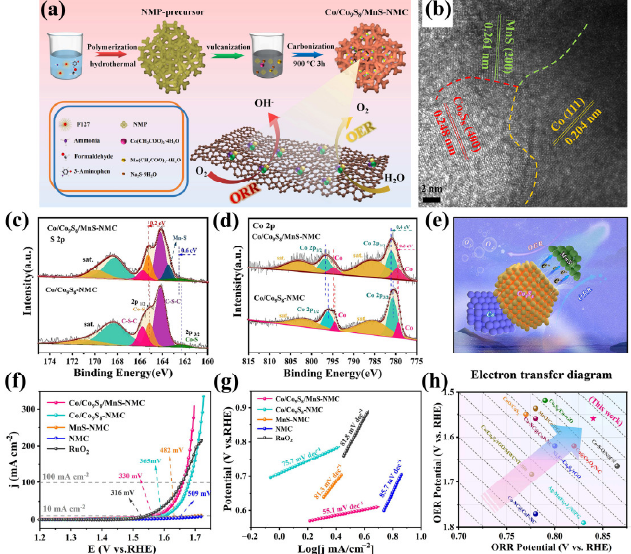
Figure 8. ( a ) Preparation process for Co/Co 9 S 8 /MnS-NMC. ( b ) HRTEM images of the Co/Co 9 S 8 /MnS- NMC. ( c ) S 2p XPS spectra and ( d ) Co 2p XPS spectra for Co/Co 9 S 8 /MnS-NMC and Co/Co 9 S 8 -NMC. ( e ) The electron transfer between Mo–Schoky Co/Co 9 S 8 structure and MnS species in Co/Co 9 S 8 /MnS-NMC. ( f ) OER polarization curves of Co/Co 9 S 8 /MnS-NMC in 1.0 M KOH, with a scan rate of 10 mV s −1 . ( g ) Corresponding Tafel plots for all investigated catalysts. ( h ) Comparison of OER and ORR activities of Co/Co 9 S 8 /MnS-NMC with representative samples. Reproduced with permis- sion from Ref. [90]. Copyright 2022, Elsevier B.V. 3.3. Self-Supporting Conductive Substrate Strategy Most transition metal-based catalysts used for water electrolysis are prepared on binder solid electrode support, which reduces the activity and durability of the catalyst system. In this regard, catalysts derived from a self-loaded metal–organic framework (MOF) have been introduced with a good conductivity, a high electrocatalytic surface area, enhanced mechanical stability, and strong catalyst–support interactions [91–96]. MOFs are porous crystalline materials in which the metal centers are connected by coor- dination bonds via organic bridging ligands to synthesize core–shell and hollow struc- tures. Self-supporting MOF-derived catalyst systems can be designed by controlling sur- face and interface properties (Figure 9a). A self-supporting catalyst was grown directly on a 3D solid and conductive support in situ without the use of any binders or additives. In general, a catalyst film is grown using nickel foam, carbon cloth, copper foam, and carbon fiber paper as the conductive support (Figure 9b) [97]. Figure 9. ( a ) Illustration of the interfacial engineering of heterogeneous catalysts. ( b ) Synthesis of self-supported catalyst systems for the electrocatalytic water spliing. Reproduced with permission from Ref. [97]. Copyright 2020, Wiley-VCH. Furthermore, Zhao et al. found that the metal fabrication of a self-supported elec- trode on the substrate can effectively improve its inherent performance, making the sys- tem an efficient electrocatalytic electrode. The increased surface area or roughness and the